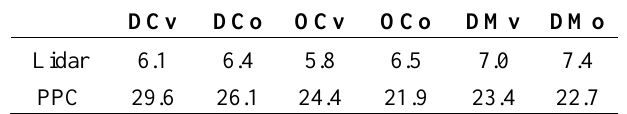
Table 5. Density of points (points/m 2 ) for lidar first returns and PPCs for each site.